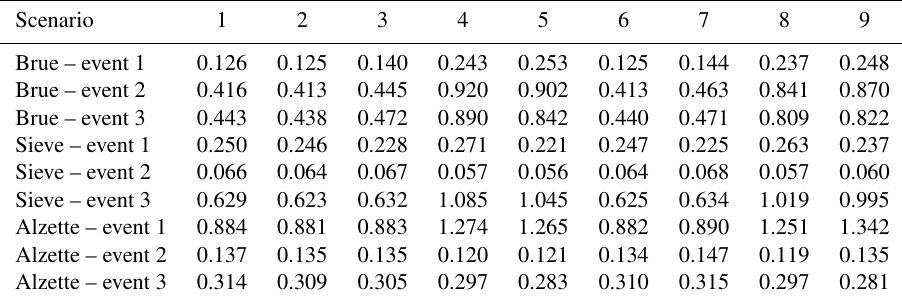
Table 1. N SE improvements (%), from 1 to 50 CSD, for different experimental scenarios during the nine flood events that occurred in the Brue, Sieve, and Alzette